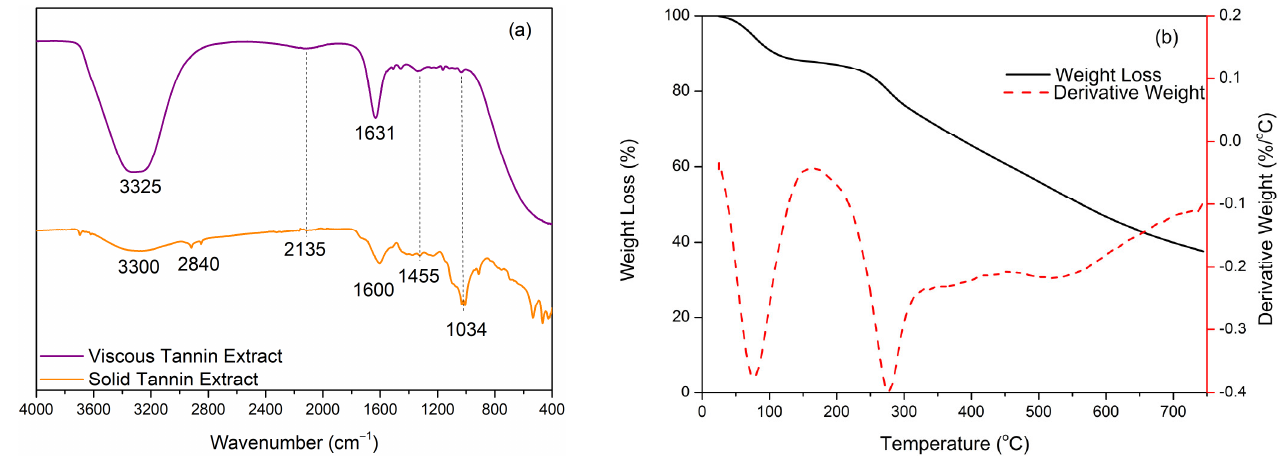
Figure 1. Properties of tannin extract: ( a ) FTIR ( b ) TGA/DTG.